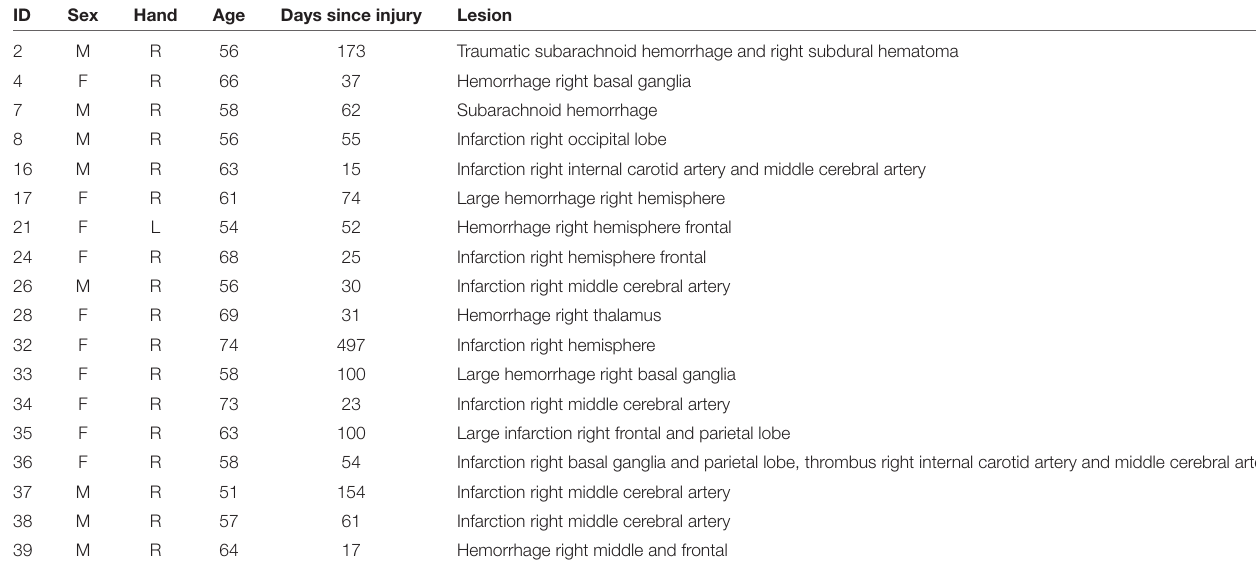
TABLE 2 | Patient demographics and brain injury characteristics.